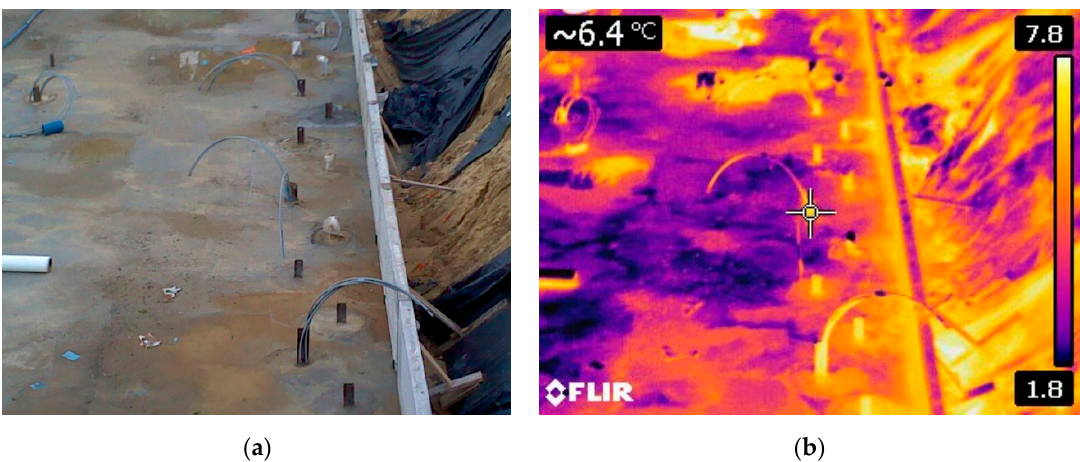
Figure 7. ( a ) A photo of the energy piles layout for the building of the National Archives in Krakow, and ( b ) a photo with a thermal imaging camera.